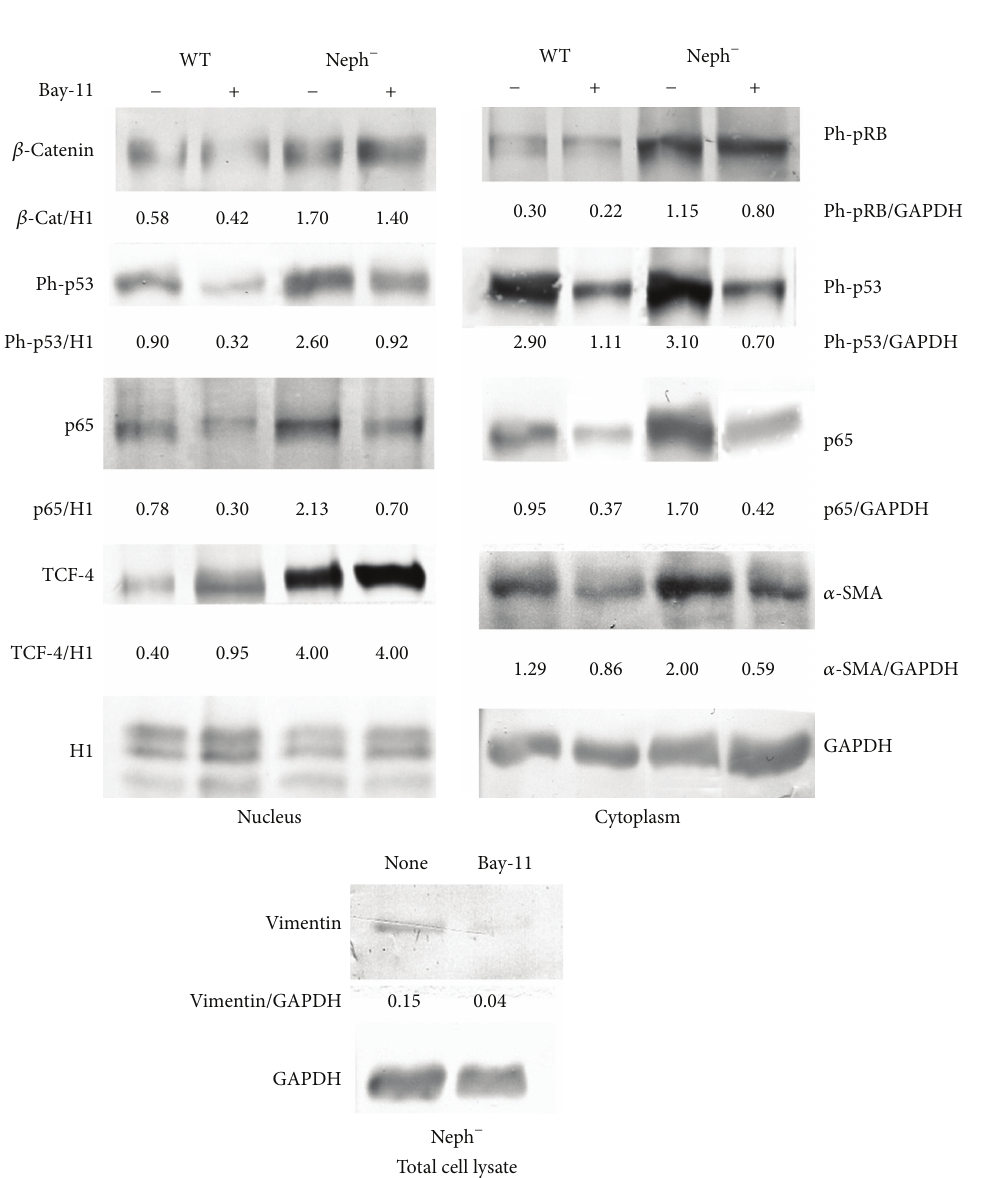
Figure 7: Effects of Bay-117082 on the distribution and expression of p53 and its phosphorylated form, phosphorylated pRB, 𝛽 -catenin, a- SMA, vimentin, and p65 in wild type and nephrin-mutated podocytes. Where indicated, the cells were treated with Bay-117082 (Calbiochem, USA) at 0.5 mM for 4 days (in the figure indicated as Bay-11). Afterwards, they were lysated, fractionated, and processed for western blot as described in Section 2. The antibodies used have been described in the previous figures. To quantify the protein bands, we scanned the blots and performed a densitometry analysis, using the software NIH ImageJ v. 6.4 (freeware, NIH, MD, USA). The figure shows a typical experiment of at least three performed under the same